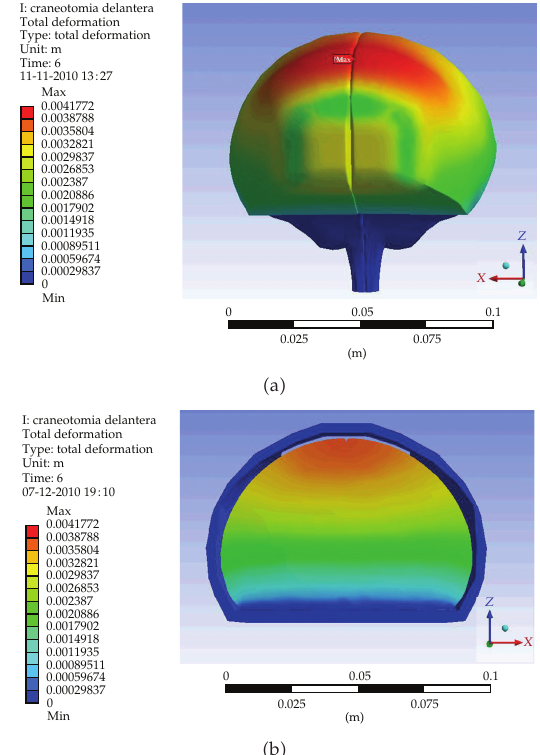
Figure 13: Brain displacement for frontal craniotomy, hyperelastic second-order Ogden